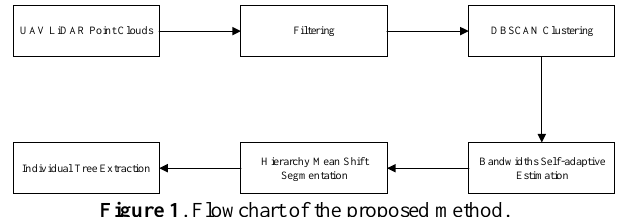
Figure 1 . Flowchart of the proposed